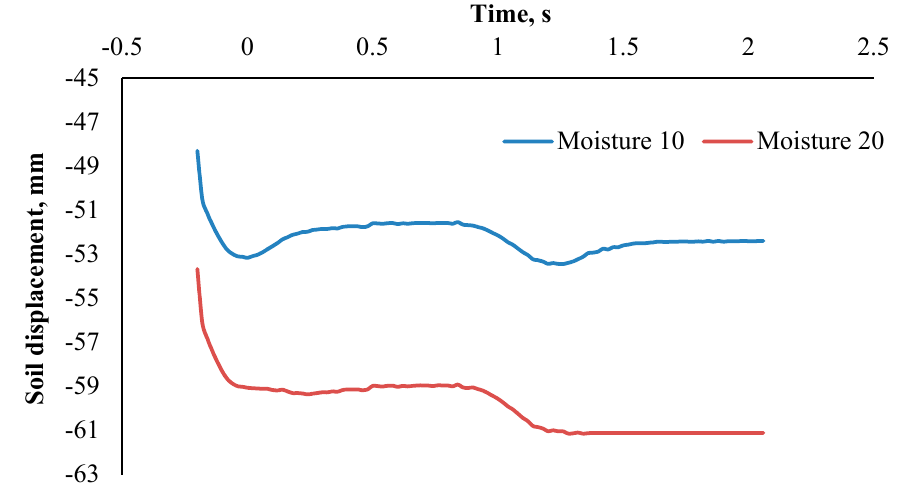
Figure 13. Soil displacement along the vertical (z) directions in mode of FWD at different soil moisture contents (d.b).